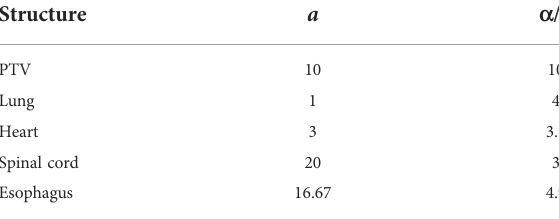
TABLE 2 Parameters of each structure in EUD model.